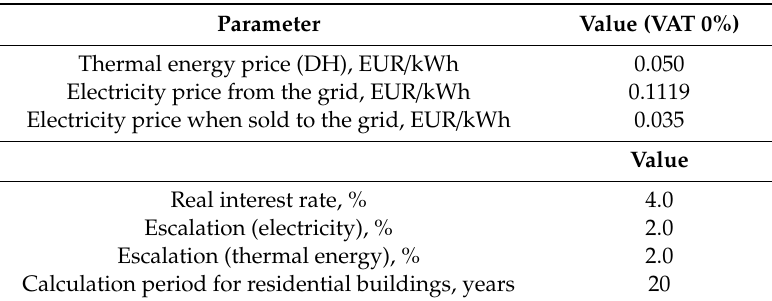
Table 3. Parameter values used for